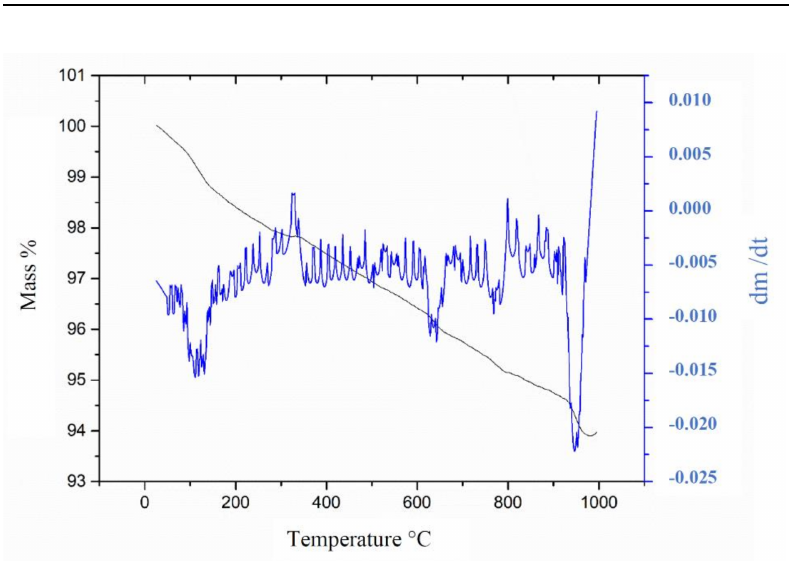
Figure 7. WFES TG and DTG